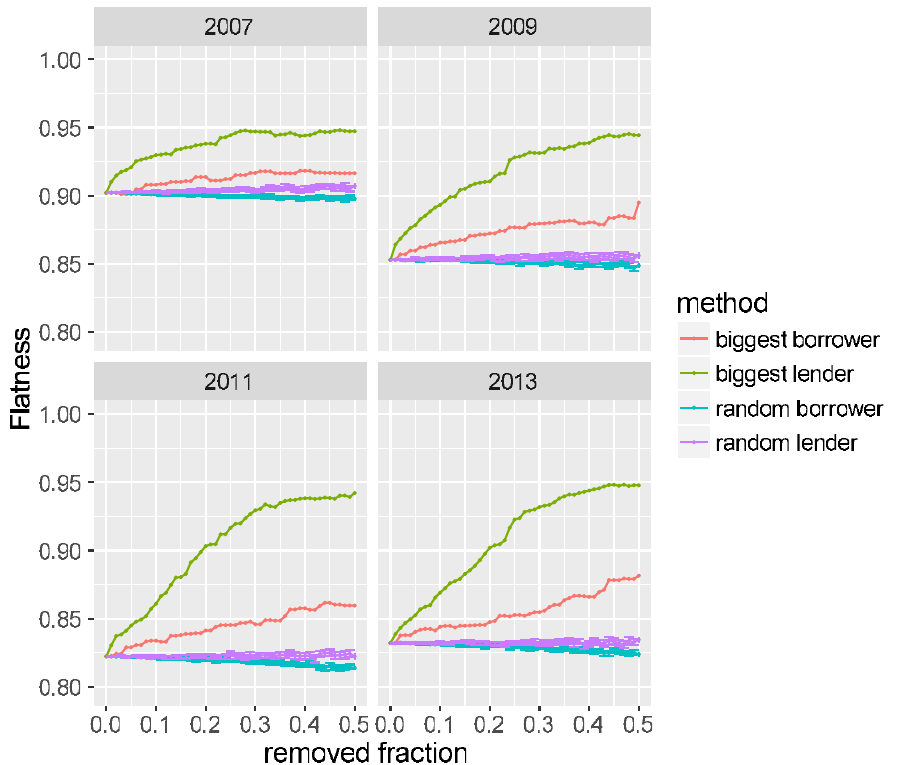
Fig 6. Simulated shocks: The effect of node removal. Change in flatness (defined as the fraction of unbiased links in the network) of the system as a function of removed fraction of nodes for different selection methods and for a few selected years (other years show a similar trend). The error bars correspond to ± 2 standard error for the random borrower and random lender case. The plots suggest that when nodes are removed randomly, the system flatness does not change; however, removing the biggest lenders or borrowers drives the system towards a more flat